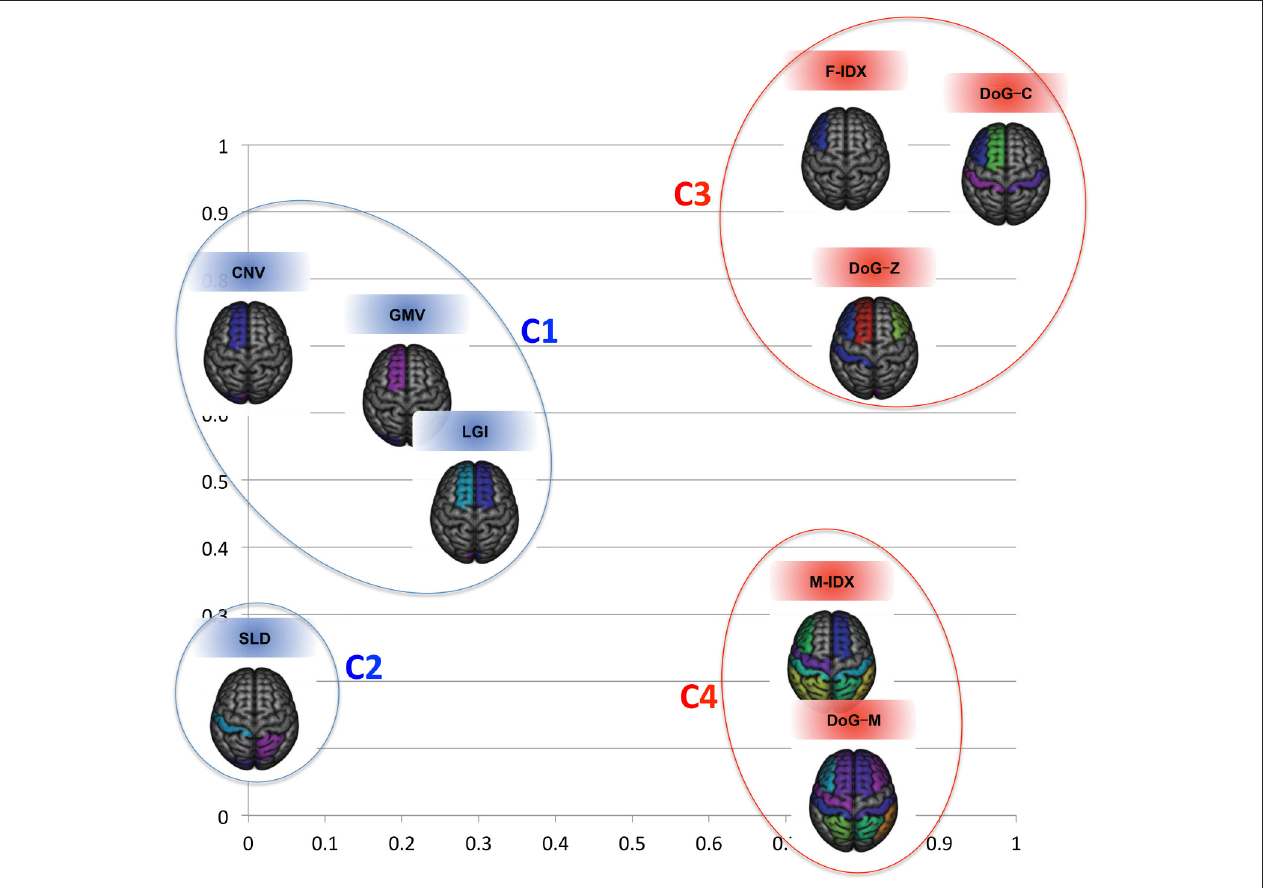
FIGURE 4 | The clustering results for the nine views in the 2D space. The structural and functional features are substantially separated when considering the first two